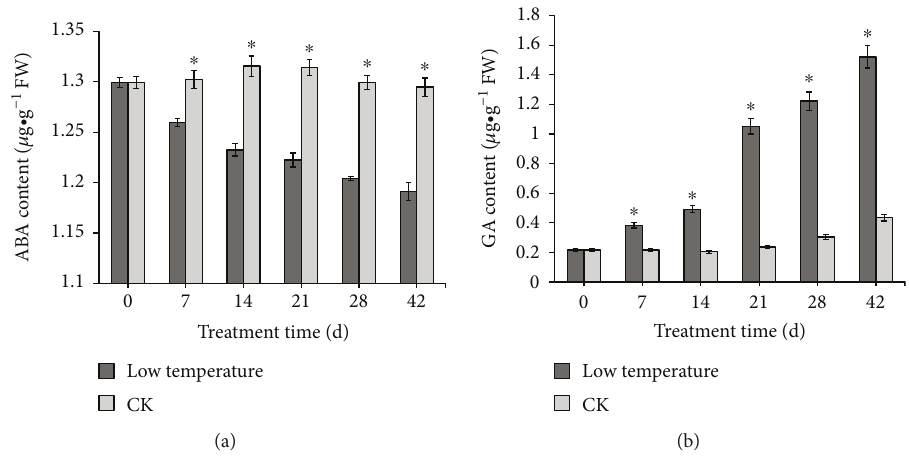
Figure 6: Content of ABA (a) and GA (b) in aerial bulbs treated with low